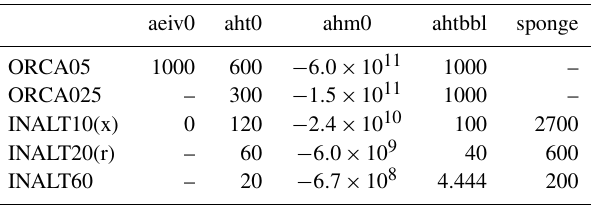
Table 2. Resolution-dependent parameters for the different config- urations: eddy-induced velocity coefficient (aeiv0; in m 2 s − 1 ); hor- izontal eddy diffusivity coefficients for tracer (aht0; in m 2 s − 1 ) and